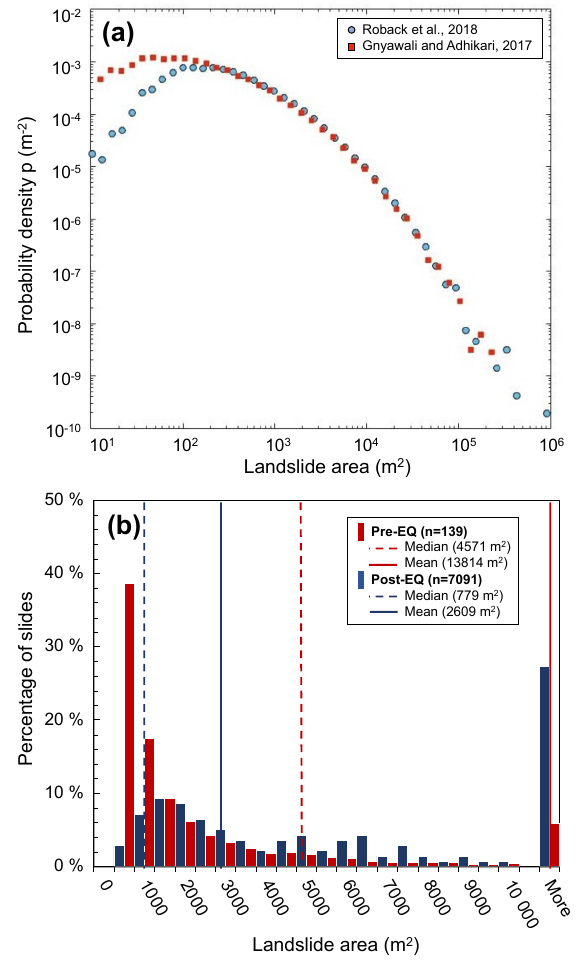
Figure 4. (a) Probability density–landslide area statistics of the Gorkha earthquake triggered landslide inventory used in this study compared to the inventory generated by Roback et al. (2018). The two curves diverge at slides with areas less than around 200m 2 sug- gesting that the Gnyawali and Adhikari (2017) data selected more smaller slides. (b) Histograms of normalized areas of landslides present before and after the 2015 Gorkha earthquake. The higher mean and median values for the monsoon-generated landslides as compared to the earthquake-generated landslides may likely reflect missed smaller, older landslides that were covered by vegetation (Malamud et al.,